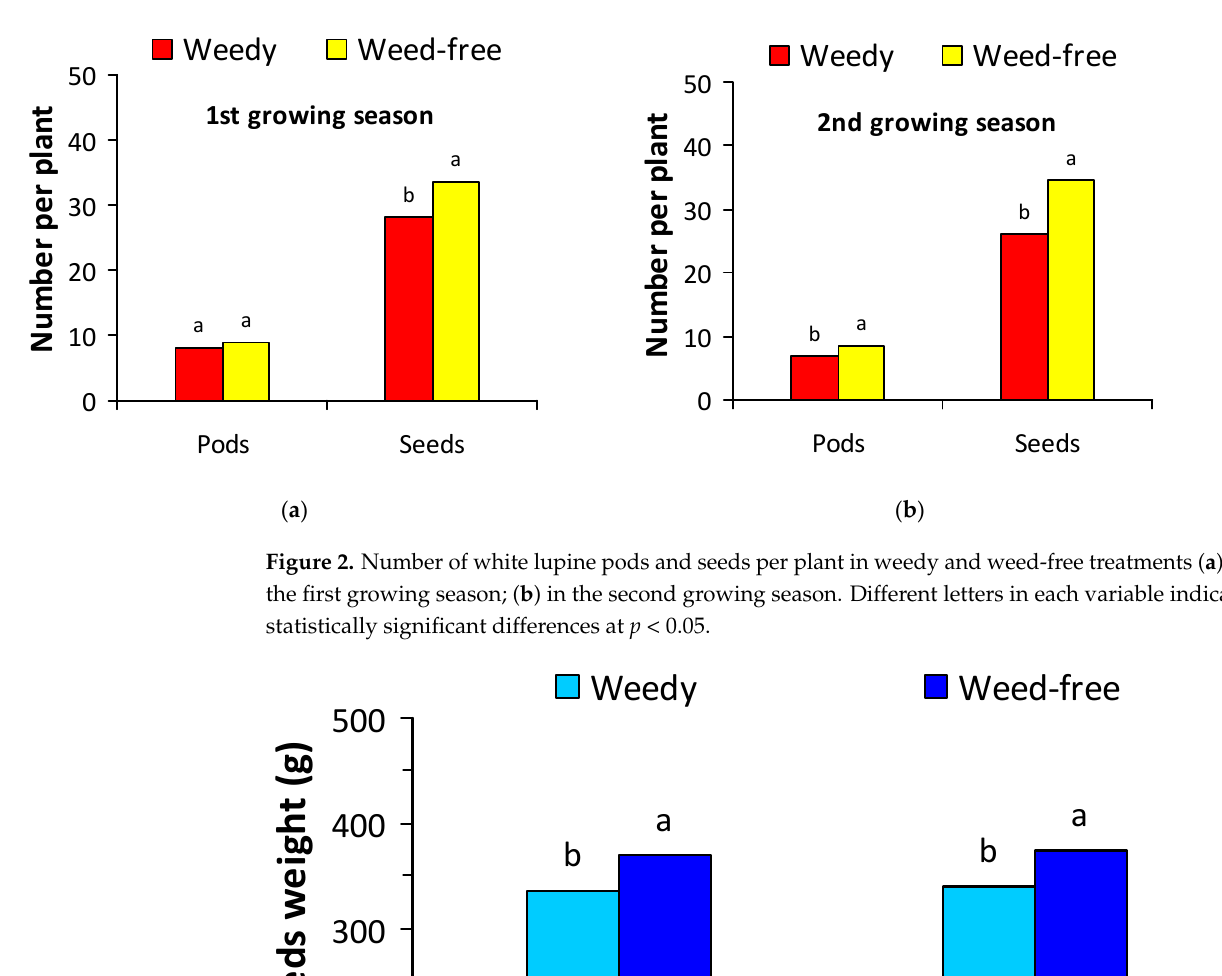
Figure 3. Thousand ‐ seeds weight of white lupine in weedy and weed ‐ free treatments in the first and second growing seasons. Different letters in each growing season indicate statistically signifi ‐ cant differences at p < 0.05.